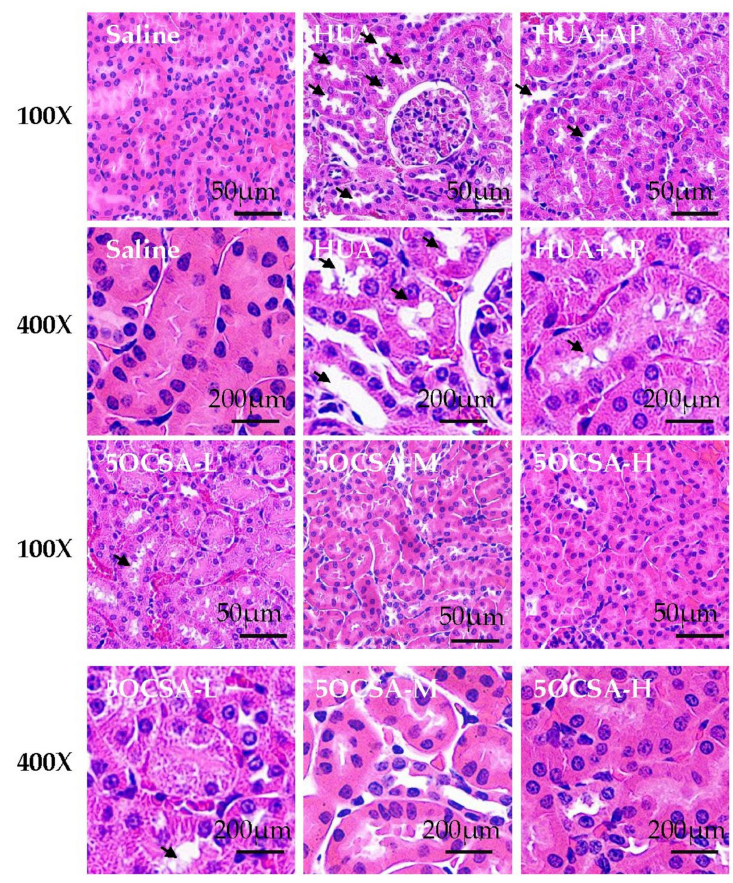
Figure 5. Protective effects of 5OCSA on kidney histomorphometry change caused by PO/HX in mice. The right kidney of mice was fixed, embedded in paraffin, sectioned, and stained by H&E. Arrows indicate the enlarged vacuoles in renal tubular epithelial cells. 100 × : 100-fold magnification; 400 × : 400-fold magnification; 5OCSA: 5- O -caffeoylshikimic acid; 5 OCSA-L: low dose of 5OCSA; 5OCSA-M: medium dose of 5OCSA; 5OCSA-H: high dose of